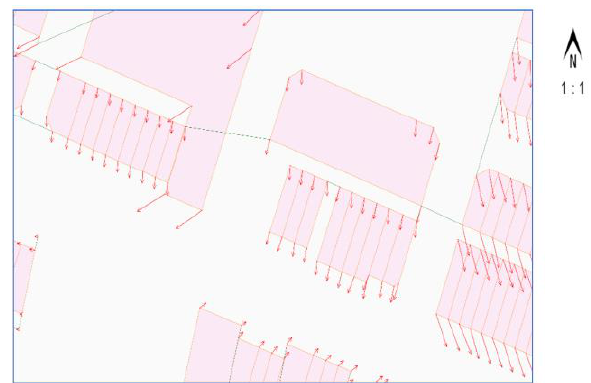
Figure 8. Correction Vectors of the Adjustment